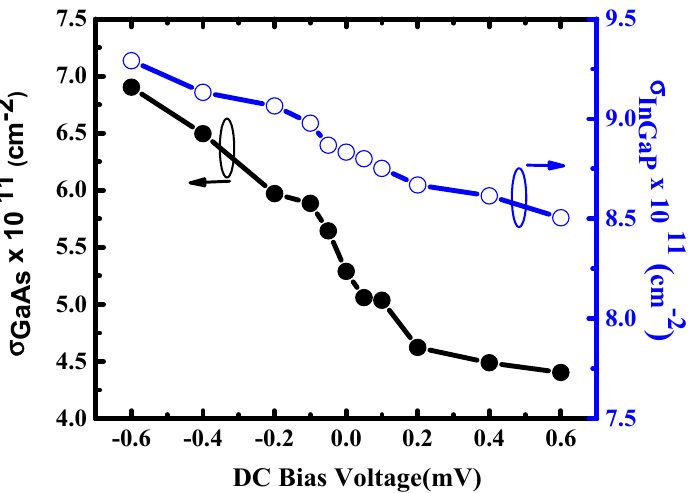
Figure 6. The number of carrier density caused by electrical bias voltage in InGaP (open circle) and GaAs (solid circle) as a function of the DC bias voltage at 300 K.